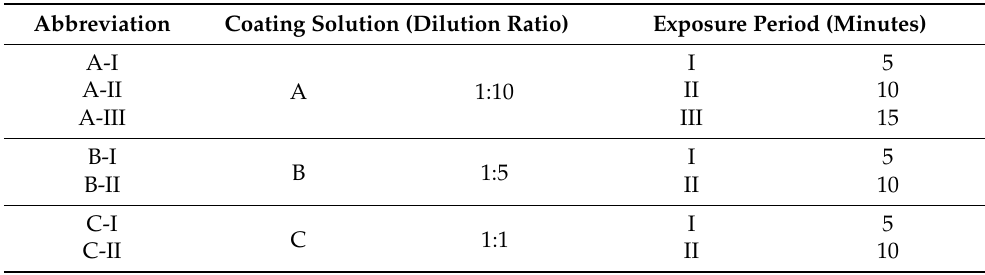
Table 2. The seven Sol-Gel coated materials produced from the Catsan (CAT) material, and their different coating dilution ratios (A, B and C) and exposure periods (I, II and